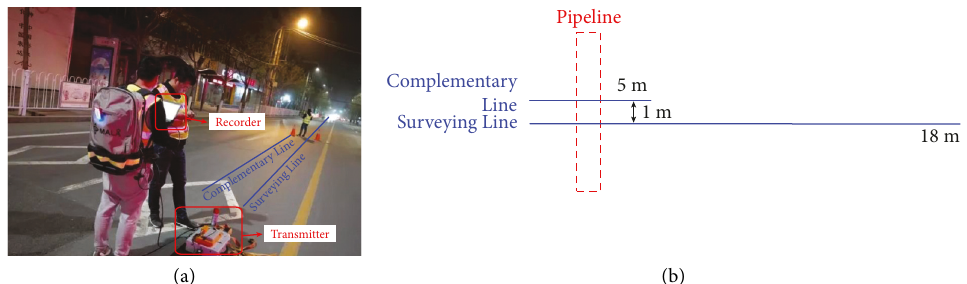
Figure 3: Data acquisition for pipeline leakage survey: (a) experimental setup for synthetic data; (b) schematic diagram for the detecting lines.